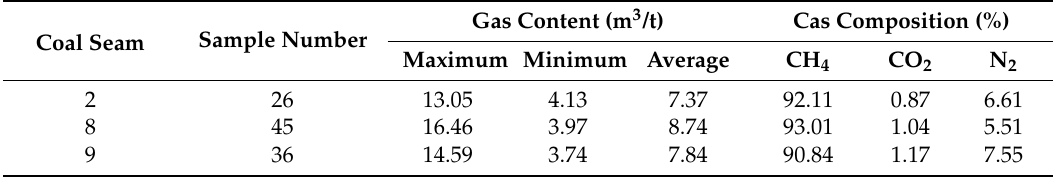
Table 1. Statistical gas content and composition of the main coal seams in the Gujiao area.